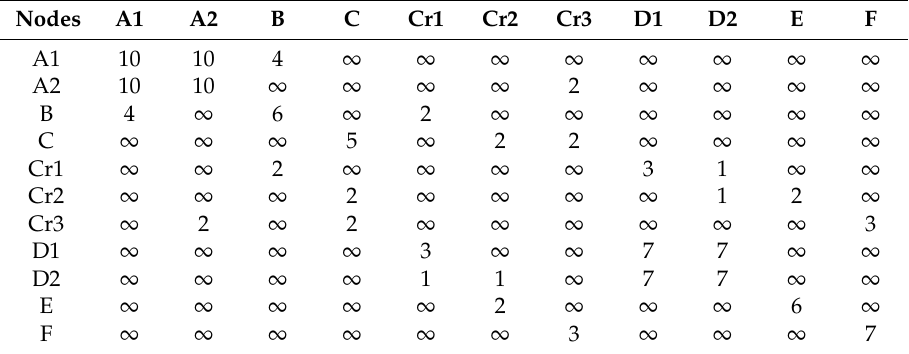
Table 1. Superior connection matrix for Figure 2 with the practical